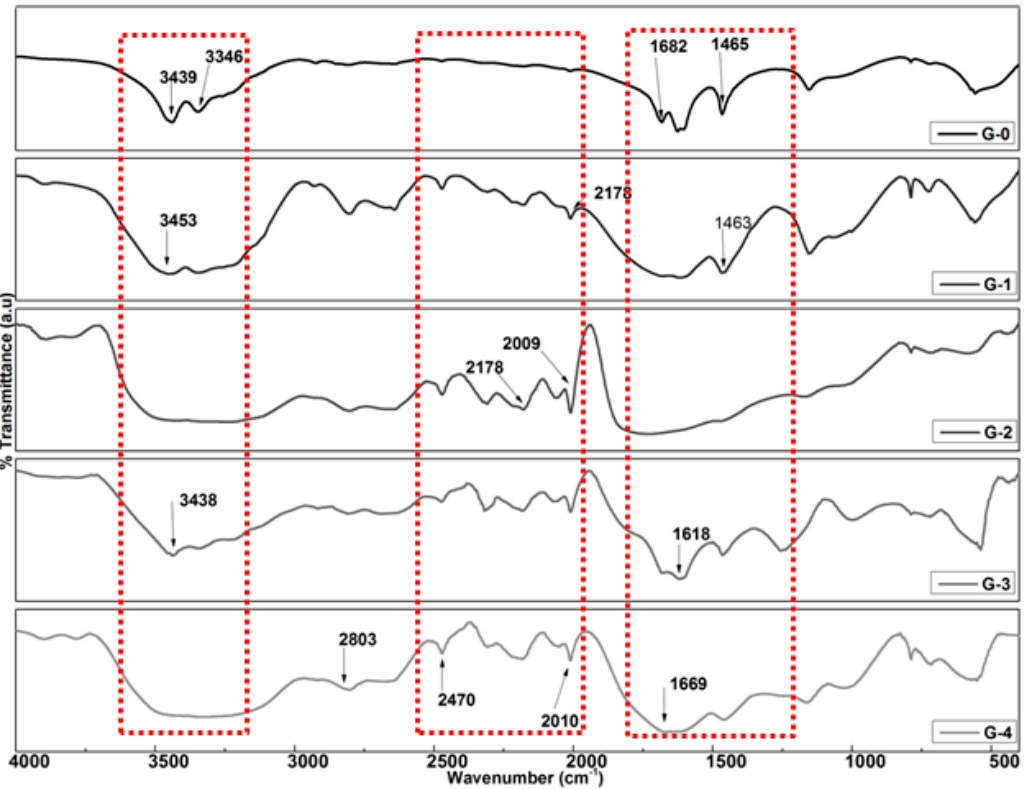
Figure 2. Fourier transform infrared (FTIR) spectra of uncoated and coated granular urea. Figure 2. FTIR spectra of uncoated and coated formulations.